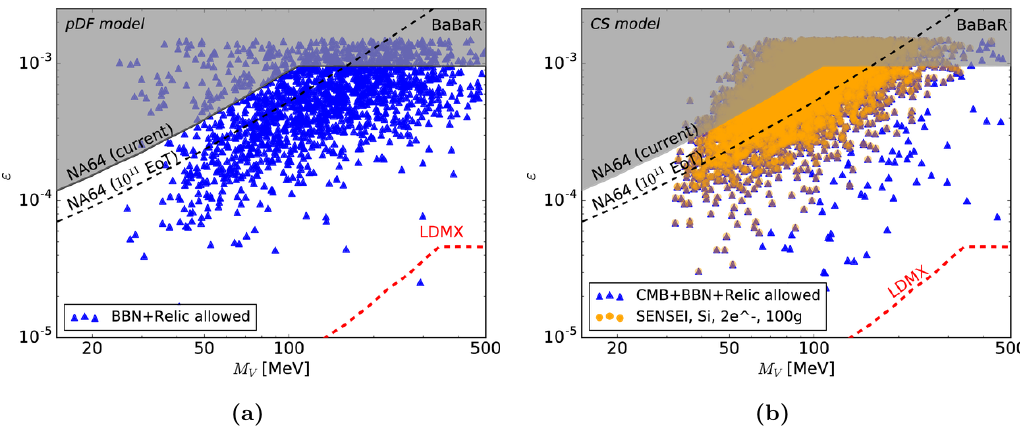
Figure 3. Constraints on the dark photon mass M V and on the kinetic mixing parameter " from NA64 and BaBaR missing energy searches, with the projected bounds on a short time scale of SENSEI [3, 60] with one year exposure of a 100g detector (bounds from one year exposure of the annual modulation signals at Xenon1T according to [61] are essentially similar) and from the full dataset of NA64 (corresponding to 10 11 electrons on target, see [3]). Points satisfying the dark matter relic density and relevant BBN and CMB constraints are shown for the pDF model (a) and for the CS case (b) . The dashed red line represents the projected LDMX bound